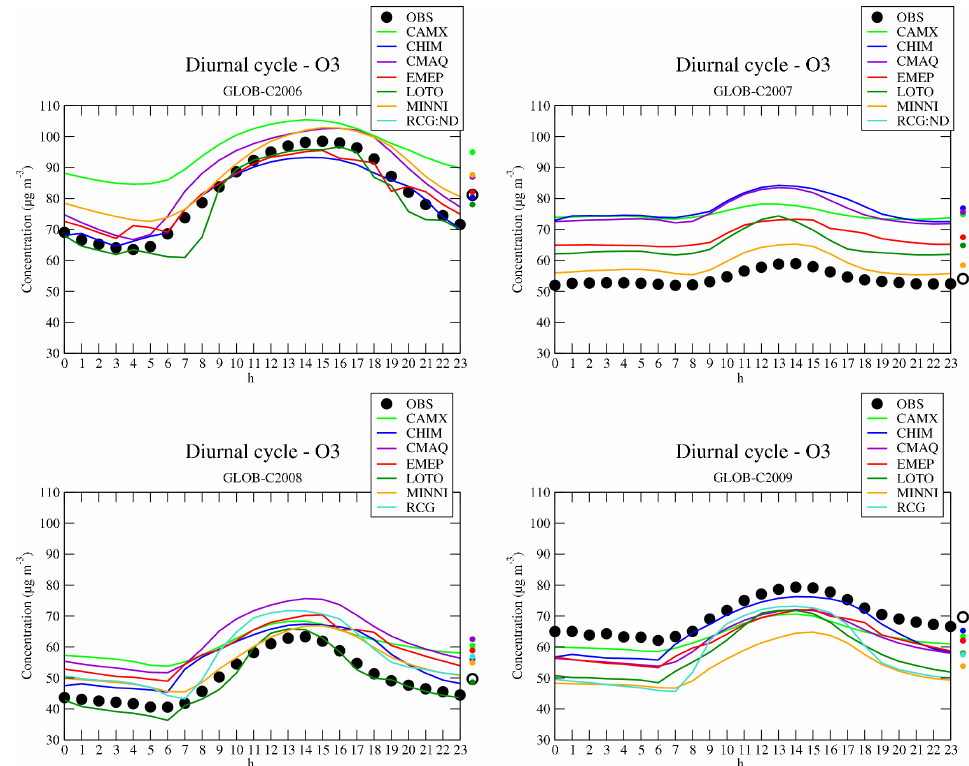
Figure 6. Mean ozone diurnal cycles for all campaigns simulated by the models compared with observations. Averaged concentrations are provided on the right side of the